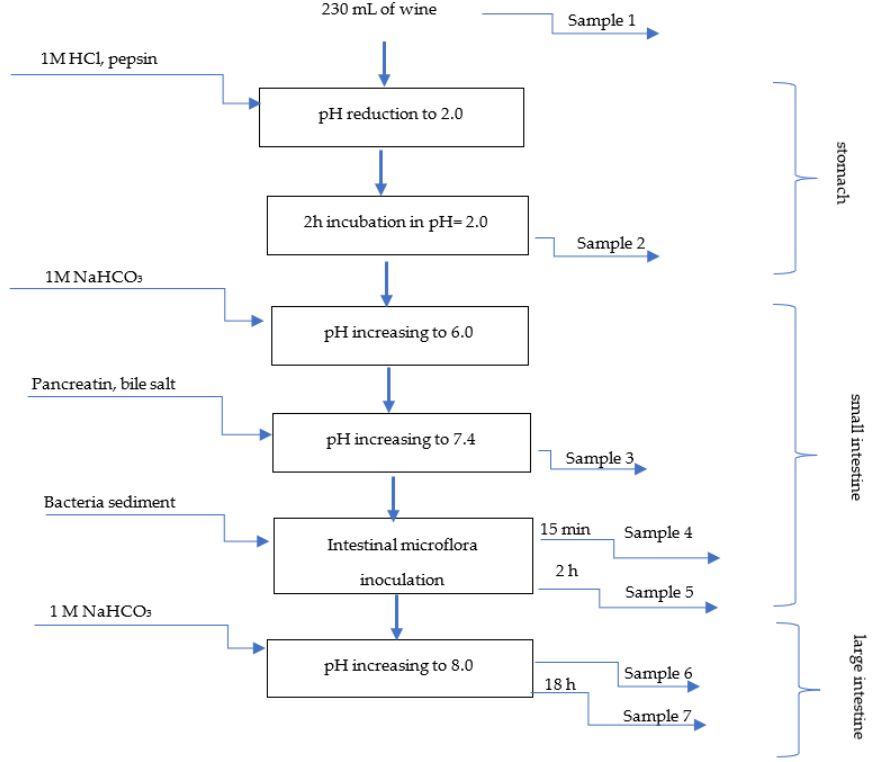
Figure 1. Diagram of in vitro gastrointestinal digestion model and sampling stages.